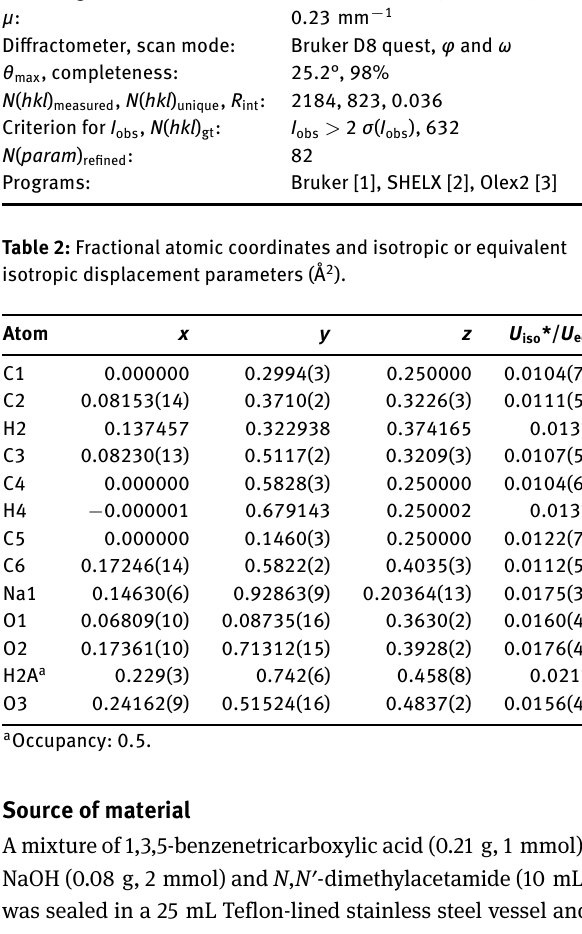
Table 1 contains crystallographic data and Table 2 contains the list of the atoms including atomic coordinates and dis- placement parameters.